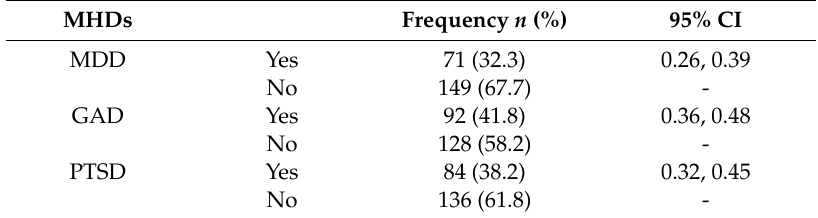
Table 2. Prevalence of mental health disorders (MHDs) among participants ( n =